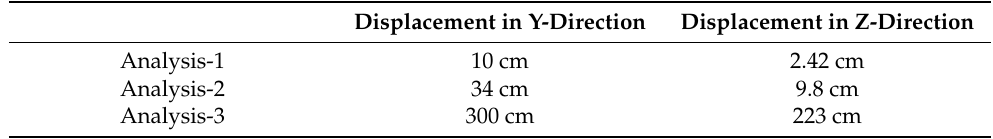
Table 3. Rock mass parameters employed during the back